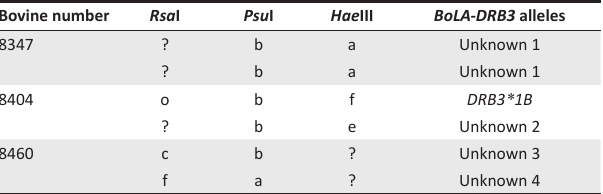
TABLE 8: The polymerase chain reaction-restriction fragment length polymorphism patterns and BoLA-DRB3 alleles obtained using three restriction